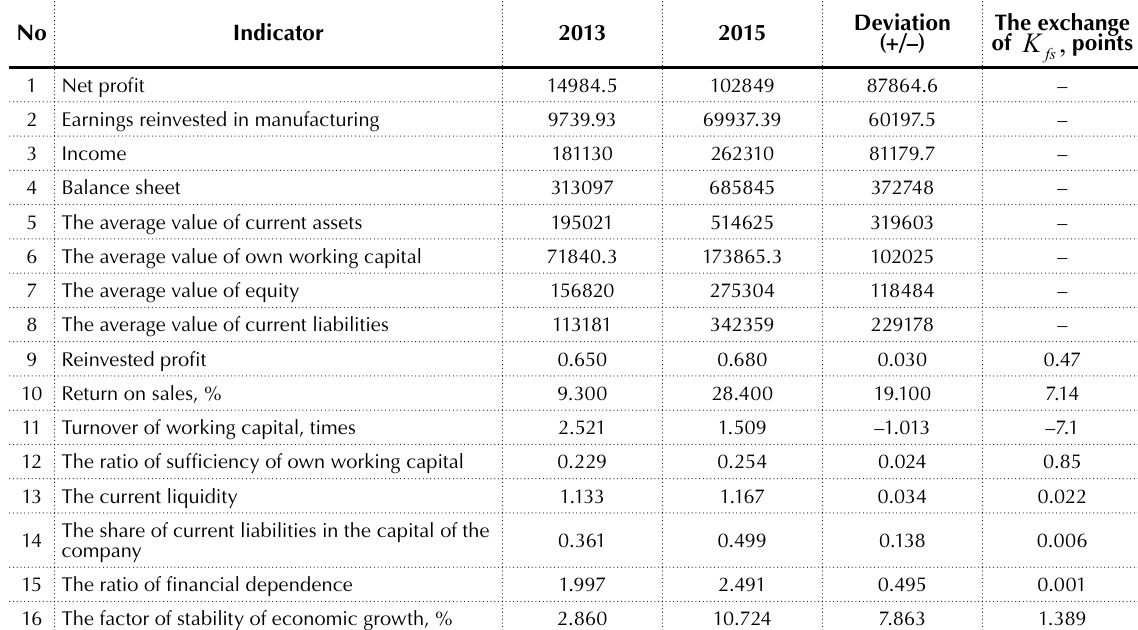
3. The growth the degree of providing by own working capital by 0.02 points led the increase K by 0.85 points: of fs